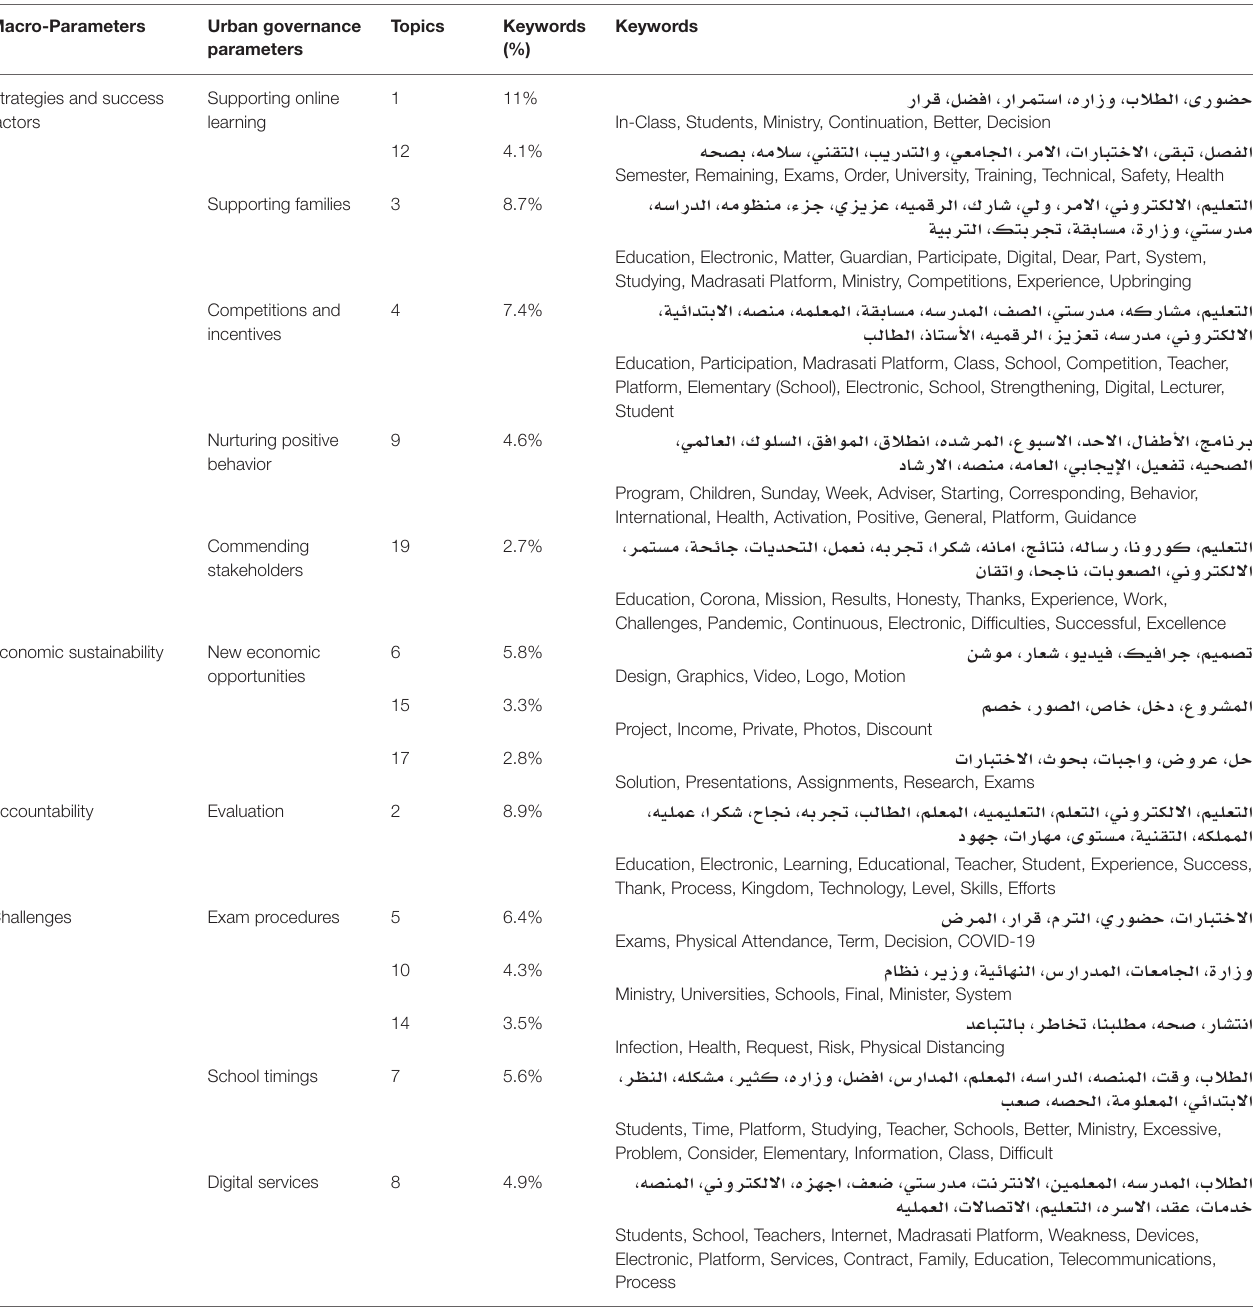
Table 3 | Urban governance parameters (online learning during COVID-19, October–December 2020).